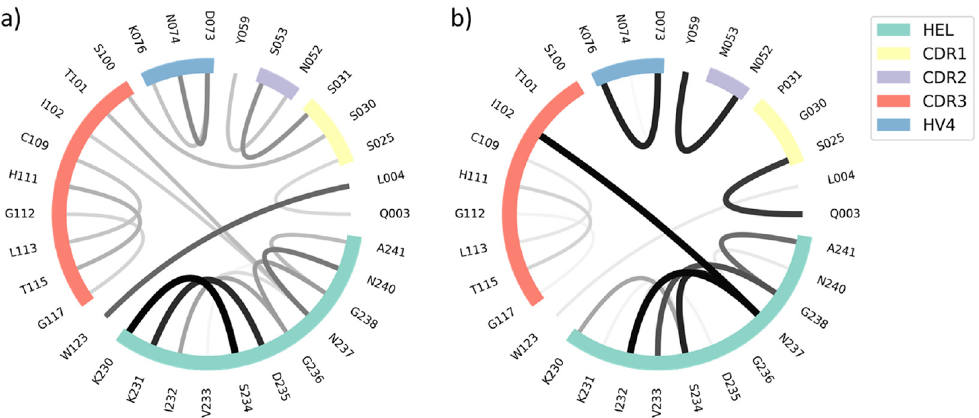
Figure 7. Flare plots showing all inter- and intramolecular hydrogen bond interactions up to the cut-off of 3.5 Å of the ( a ) cAb-gl1+2 and the ( b ) cAb variants. The residues which are part of the CDR loop regions are highlighted according to the colors of the legend. The frequencies of the interactions are represented with the width of the lines. In the variant cAb the number of interacting residues is reduced compared to the cAb-gl1+2, but the intensities are higher.